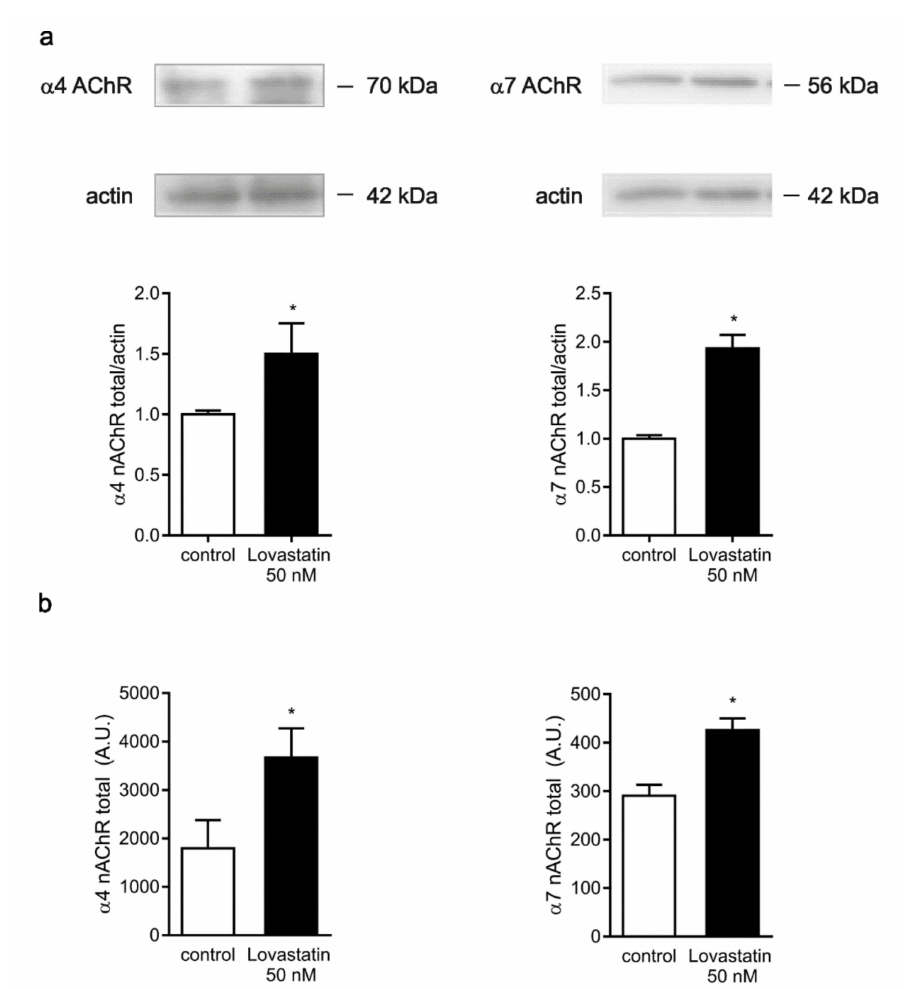
Figure 7. Lovastatin treatment increased total α 7 and α 4 nAChR levels. ( a ) α 7 and α 4 nAChR subunits revealed in immunoblots of cultured hippocampal neurons treated with 50 nM lovastatin for 14 days or left untreated (control). Actin was used as loading control. Lower panel: quantification of α 7 and α 4 nAChR subunits against actin. Data represent the mean ± SD from at least three independent experiments. ( b ) Cultured hippocampal neurons were treated with 50 nM lovastatin for 14 days or left untreated (control). At the end of the incubation, neurons were fixed, permeabilized, and labeled with Alexa Fluor 488 -BTX and mAb-299 for 1 h at room temperature. After washing, neurons were incubated with Alexa Fluor555-secondary antibody for 2 h, washed with PBS, and imaged; then, fluorescence was quantified. Data represent the mean ± SD from at least three independent experiments. * p <